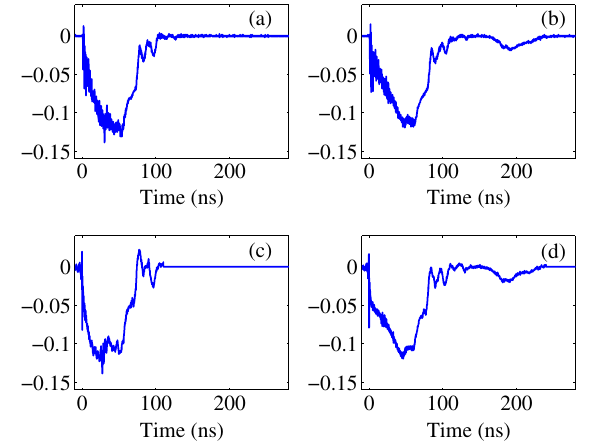
FIG. 6. Cathode images. (a) During a breakdown when light was of.f (b) After breakdown when light was on.